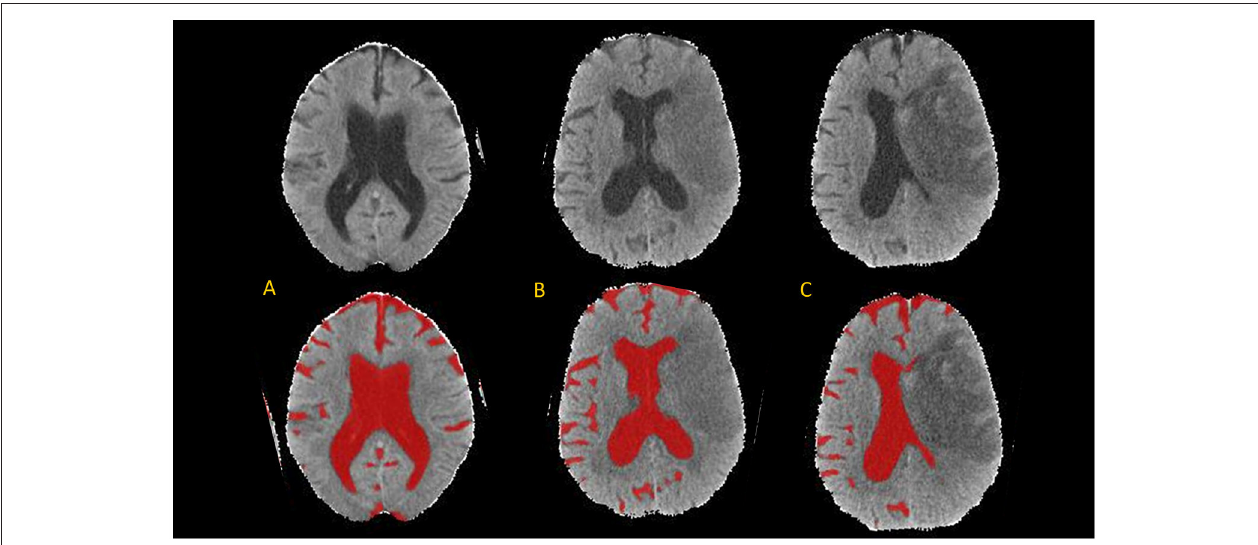
FIGURE 2 | Axial brain slices from head CT (top) and results of CSF segmentation from a 82-year old woman with initial NIHSS of 18. Baseline CT (A) was performed within 1h of stroke onset (CSF volume 224ml). First follow-up CT (B) was performed at 20-h (CSF volume 150ml) and second follow-up CT (C) at 110-h (CSF volume